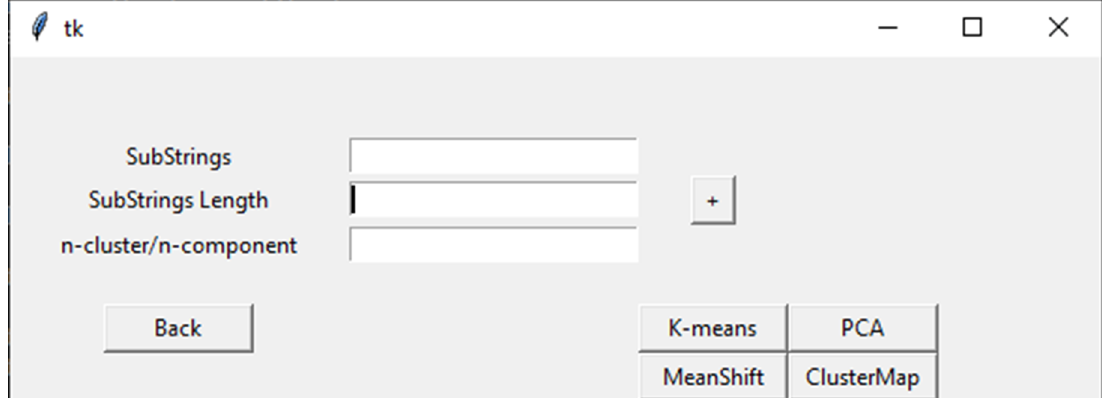
Figure 3. An overview of the Clustering page in VIRMOTIF.